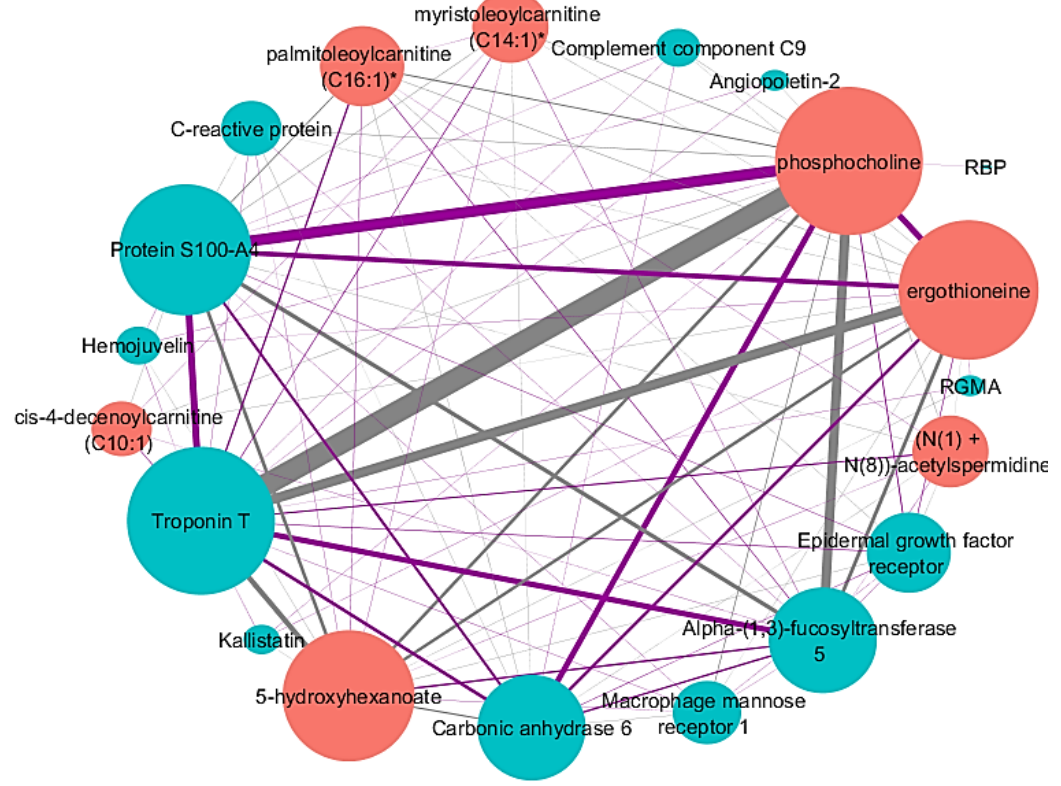
Figure 1. Identified network after applying sparse multiple canonical correlation network (SmCCNet) to adjusted proteomic and metabolomic data and FEV 1 %. Proteins are blue nodes and metabolites are red nodes. Grey edges represent a negative correlation between the nodes. Purple edges represent a positive correlation between the nodes. Edge thickness corresponds to the relationships between the nodes based on the canonical weights. Node size corresponds with connectivity. Abbreviations: retinol-binding protein (RBP), repulsive guidance molecule A (RGMA). * Indicates a compound that has not been confirmed based on a standard, but Metabolon is confident in its Table 2. Individual network node correlations to FEV 1 %.